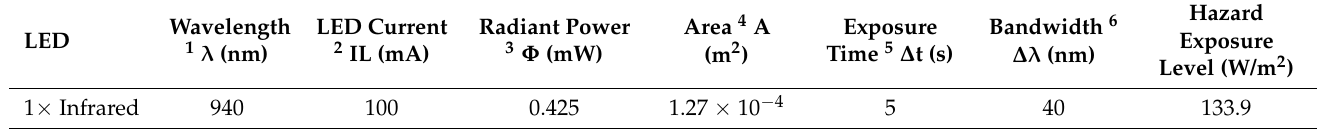
Table 3. Infrared radiation hazard exposure for the eye of a single IR